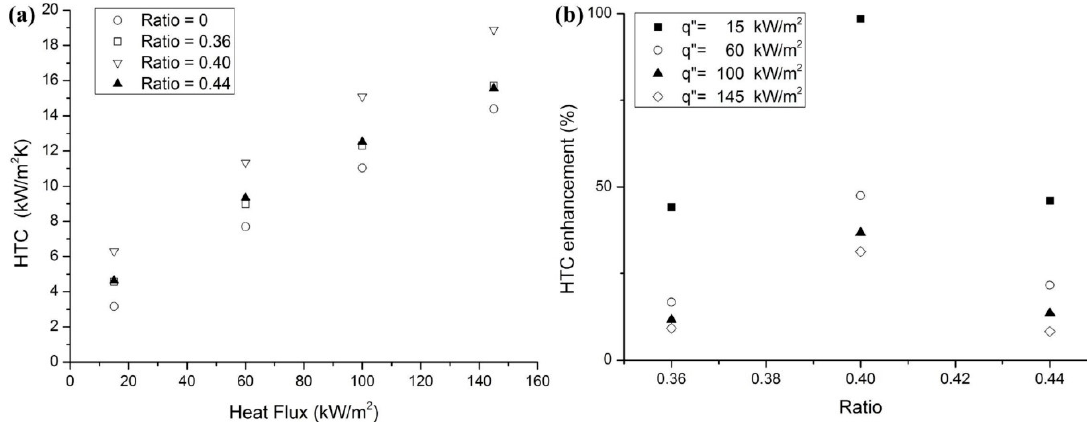
Figure 13. Bubble development mechanisms of the surfaces with ( a ) 0.36 aspect ratio and ( b ) 0.44 aspect ratio.